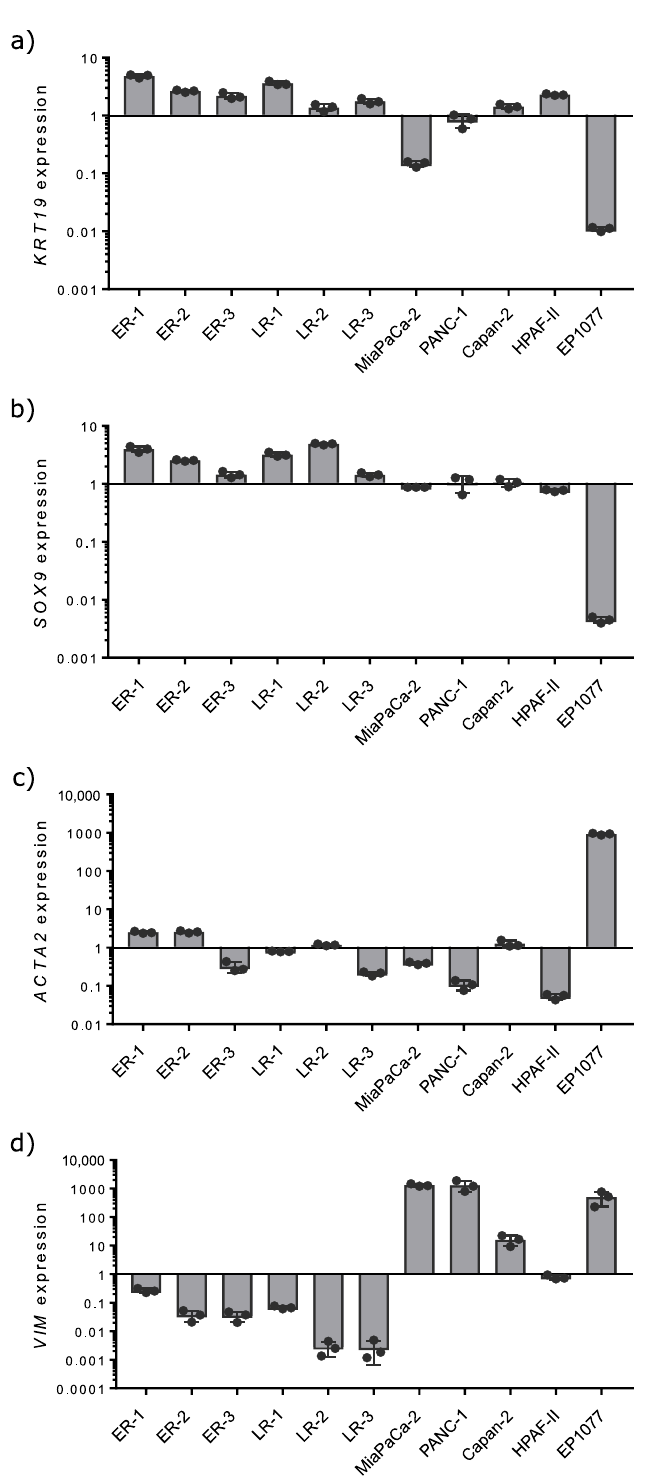
Figure 1. Gene expression analysis of epithelial, ductal and mesenchymal markers in PDOs, PDAC cell lines and PSCs. The expression of cytokeratin 19 ( KRT19 ; a ), SOX9 ( b ), alpha smooth muscle actin ( ACTA2 ; c ) and vimentin ( VIM ; d ) was analyzed by qPCR and normalized to β -actin expression. Gene expression was analyzed in early and late recurrent PDOs as well as in a pancreatic stellate cell line (EP1077) and the established PDAC cell lines Capan-2, HPAF-II, MiaPaCa-2 and PANC-1. Results are depicted in a logarithmic scale as fold change over all samples. Bar charts display mean ± standard error of the mean ( n = 3).